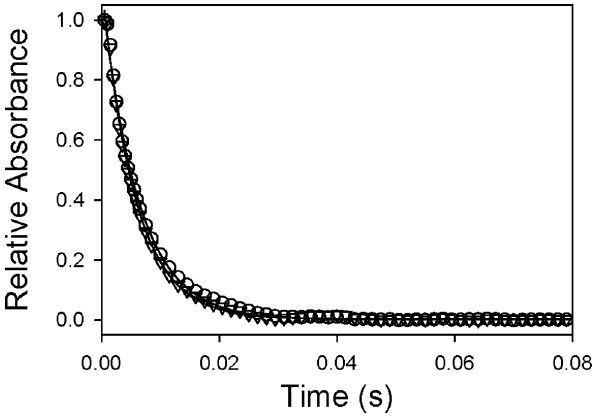
Figure 6. Stopped-flow kinetics of CO association with bb XLHb in the presence and absence of Hp. Representative time courses of CO (500 m M after mixing) binding with bb XLHb without (open circle) or with (open triangle) Hp were plotted for comparison. Both traces were fitted to single exponential equation by non-linear least squares regression